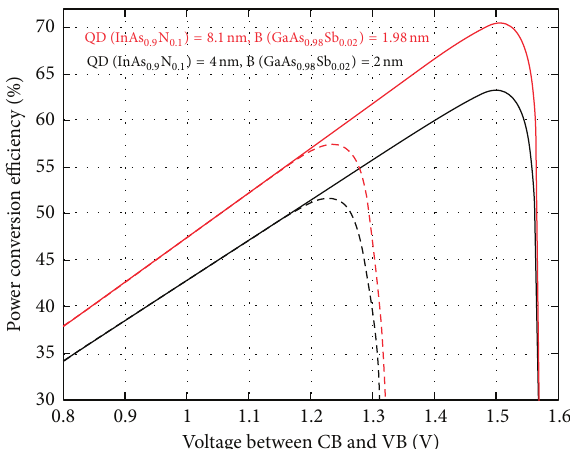
Figure 13: Power conversion efficiency for QDIBSC at full concen- tration (solid) and unconcentrated (dash) cases at specified values of quantum dot and barrier widths that give maximum